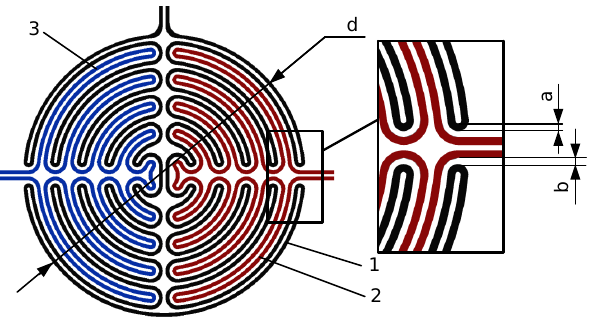
Figure 1. Electrode configuration for measuring capacity and resistivity including the ability to heat the active area (left: outer conductor (1) with a structure diameter ( d ) to heat and two conductors (2, 3) for referencing and sensing; right: dimensions of circuit path width ( a ) and distance ( b